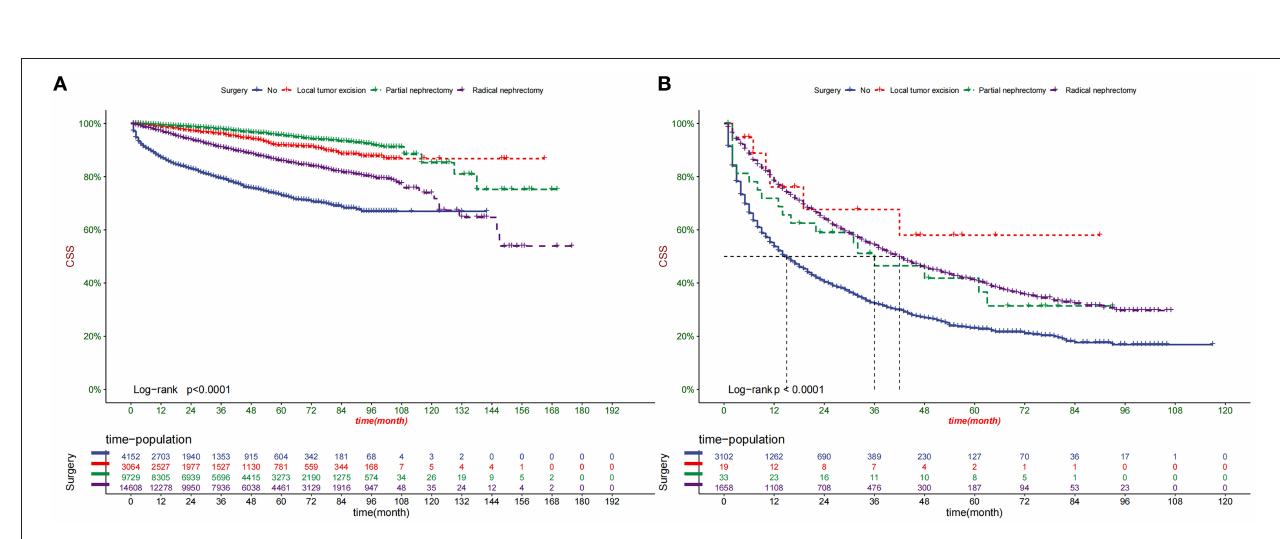
FIGURE 7 | (A) Kaplan–Meier curves of CSS for patients with different surgery in the low-risk group and (B) the high-risk group.